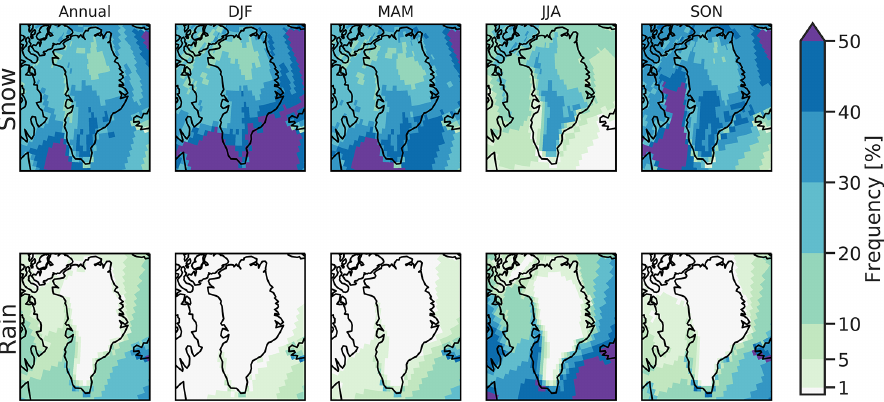
Figure 4. Present-day annual (left) and seasonal (DJF, MAM, JJA, SON, from left to right) mean total snowfall (light snow + snow, top) and total rainfall (light rain + rain, bottom) frequency as simulated by CESM (2006–2020).